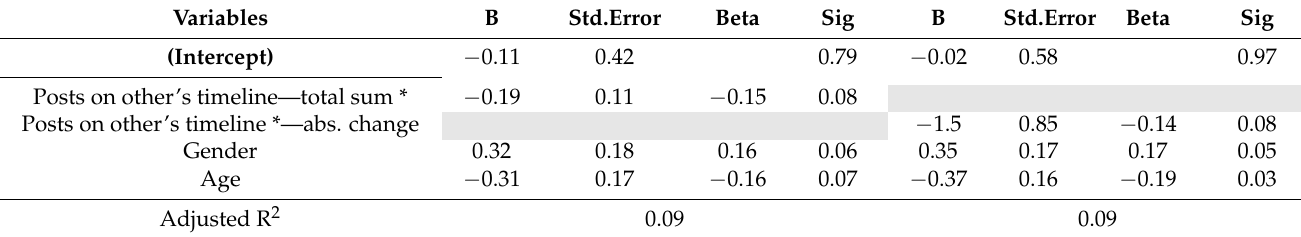
Table 5. Linear Regression model. Dependent variable: somatic depression.